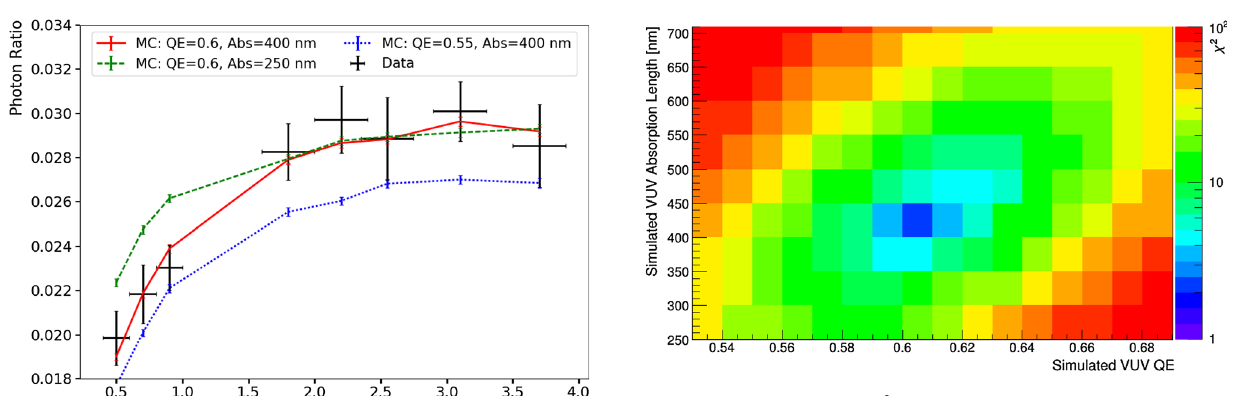
Fig. 13 A heat map of the χ 2 for a 2-D sweep of VUV QE and absorp- tion lengths for 130 nm incident light. The SQE is held fixed at 0.9. The pair of VUV QE and absorption length values that minimizes the χ 2 is 0.6 and 400 nm. The χ 2 value at the minimum is equal to